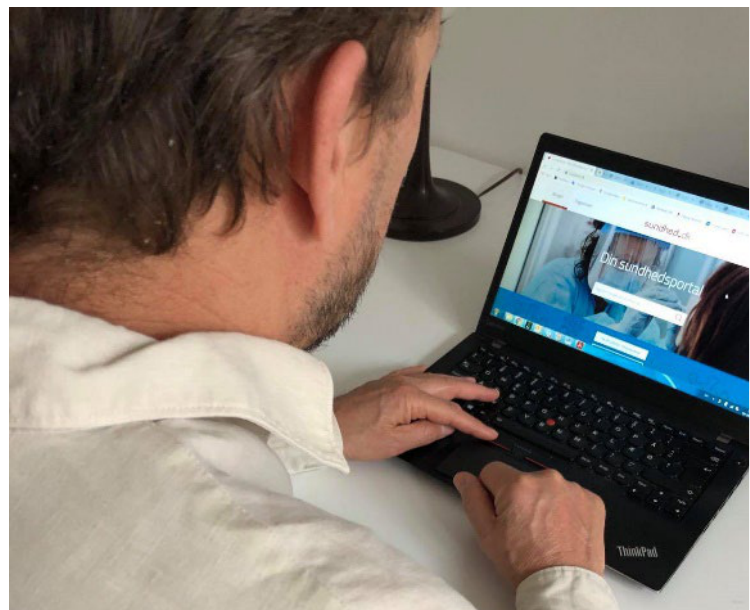
Figure 1 . John accessing Sundhed.dk from his living room. Image by Alexandra Brandt Ryborg Jønsson,